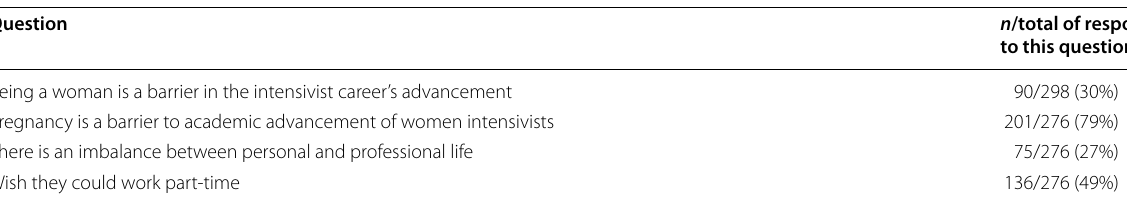
Table 4 Impact of gender in career advancement and quality of life Question